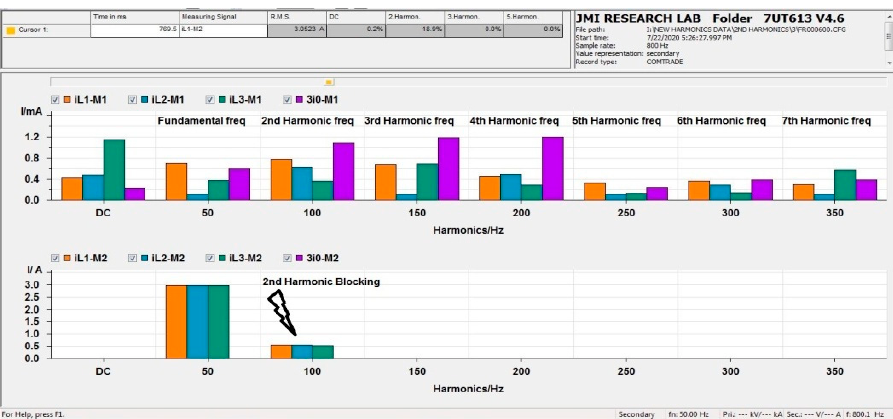
Figure 16. 2nd HB at 3000 mA Rated current & 20% of Inrush current condition.